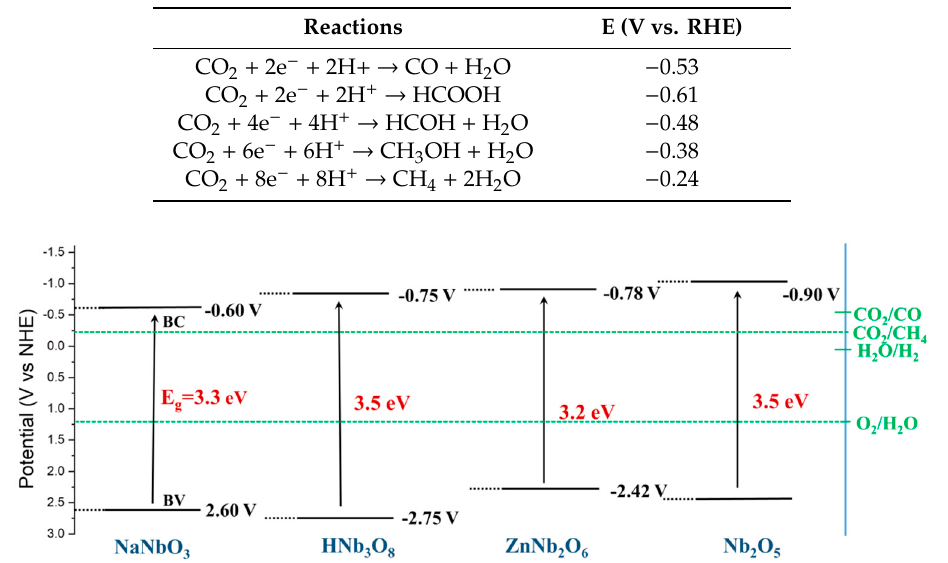
Table 3. Common products from CO 2 reduction, their simplified half reactions, and redox potentials at pH = 7.